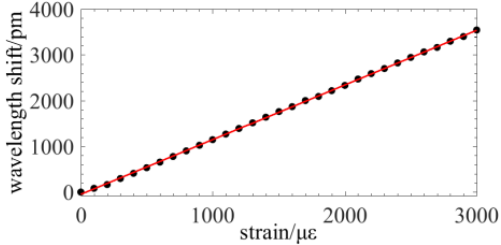
Figure 7. Experiment on the sensing nonlinearity.